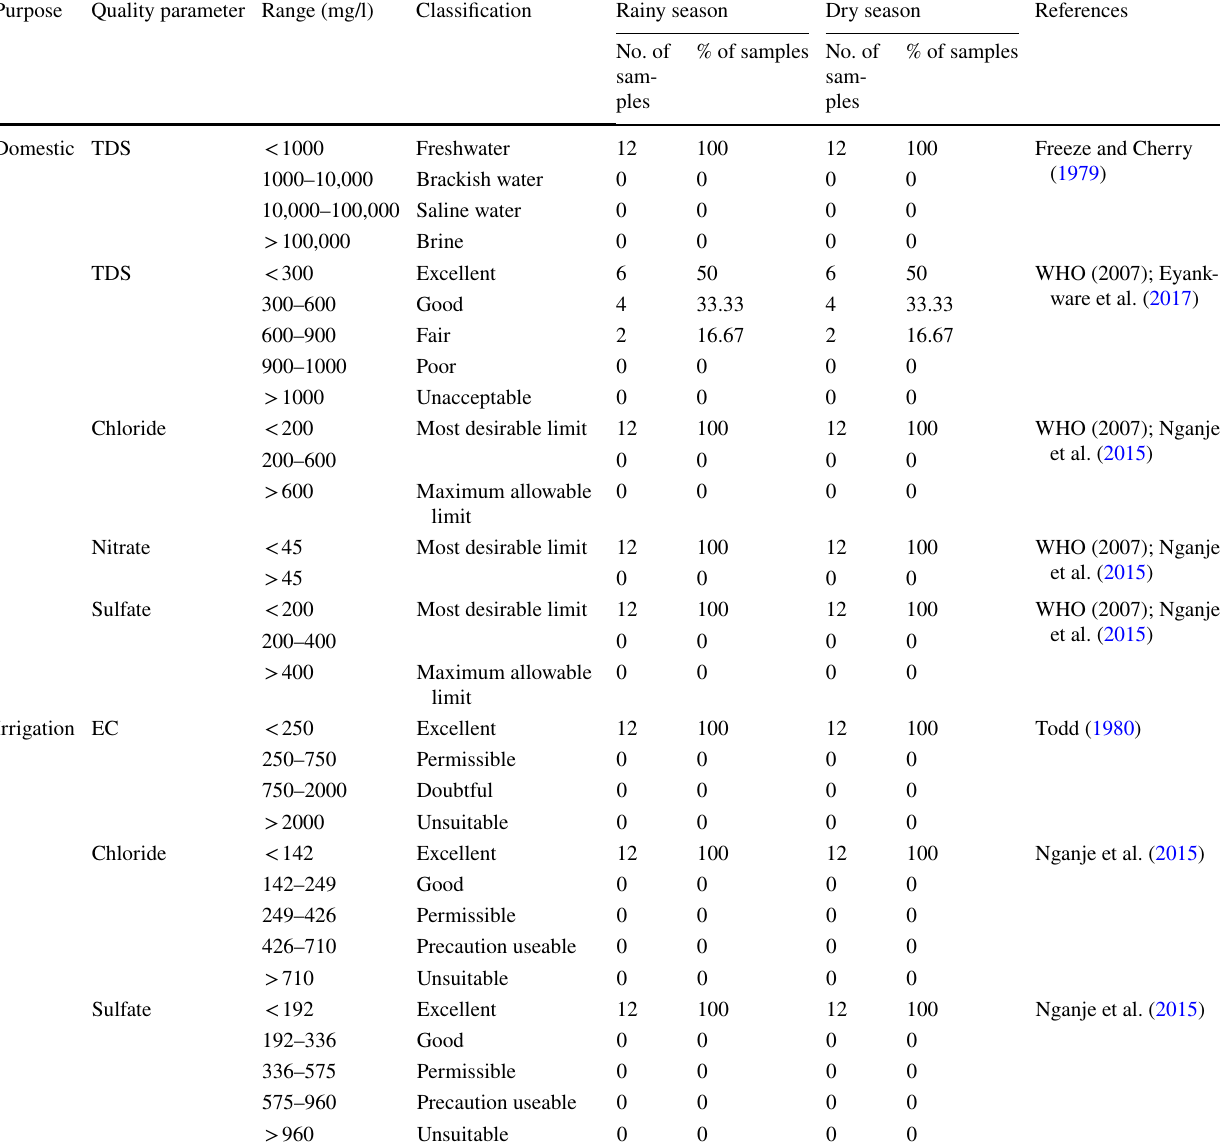
Table 9 Domestic and irrigation water class based on hydrochemicals Purpose Quality parameter Range